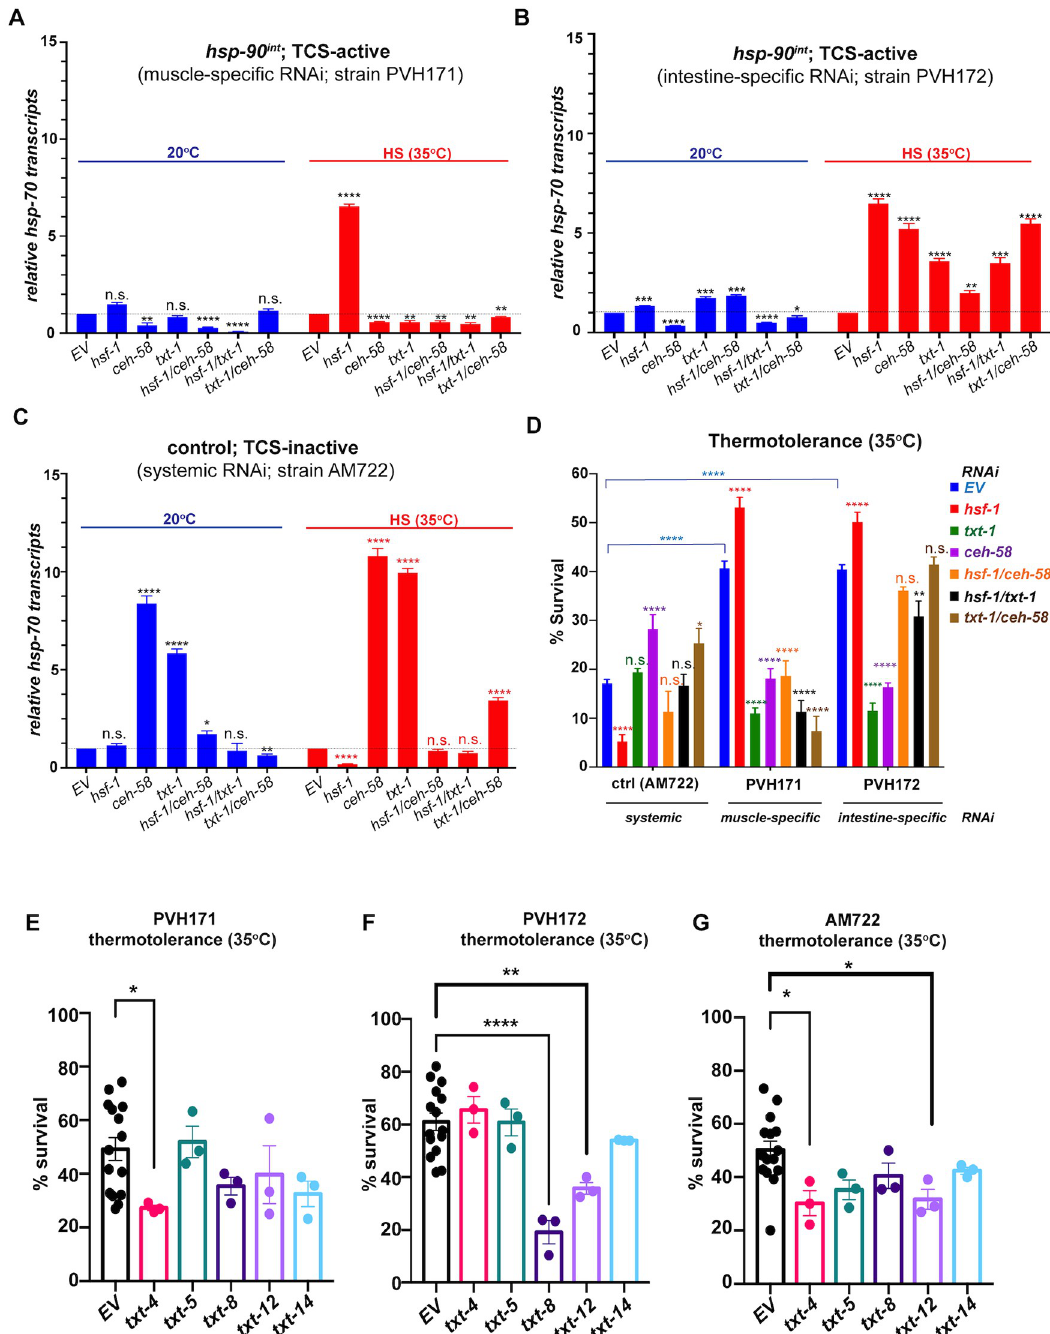
Fig 5. txt-1 is required for TCS-mediated hsp-70 induction during HS independent of hsf-1 . ( A ) TCS-mediated hsp-70 induction is facilitated by txt-1 and ceh-58 in the muscle. Quantification of whole-animal hsp-70 transcripts in hsp-90 int animals at 20˚C and HS (35˚C), during muscle-specific RNAi in (strain PVH171) against hsf-1 , ceh-58 , txt-1 , and double RNAi of hsf-1/ceh-58 hsf-1/txt-1 , txt- 1/ceh-58 . ( B ) TCS-mediated hsp-70 induction is suppressed by txt-1 in the intestine. Quantification of whole-animal hsp-70 transcripts in hsp-90 int animals at 20˚C and HS (35˚C), during intestine-specific RNAi (strain PVH172) against hsf-1 , ceh-58 , txt-1 , and double RNAi of hsf-1/ceh-58 hsf-1/txt-1 , txt-1/ceh-58 . ( C ) txt-1 and ceh-58 are suppressors of the HSR. Quantification of whole- animal hsp-70 transcripts in control animals at 20˚C and HS (35˚C), allowing for systemic RNAi (strain AM722) against hsf-1 , ceh- 58 , txt-1 , and double RNAi of hsf-1/ceh-58 hsf-1/txt-1 , txt-1/ceh-58 . ( D ) Thermotolerance after 6-h of heat stress at 35˚C of TCS active strains during muscle-specific RNAi (strains PVH171) and intestine-specific RNAi (strain PVH172) compared to a control